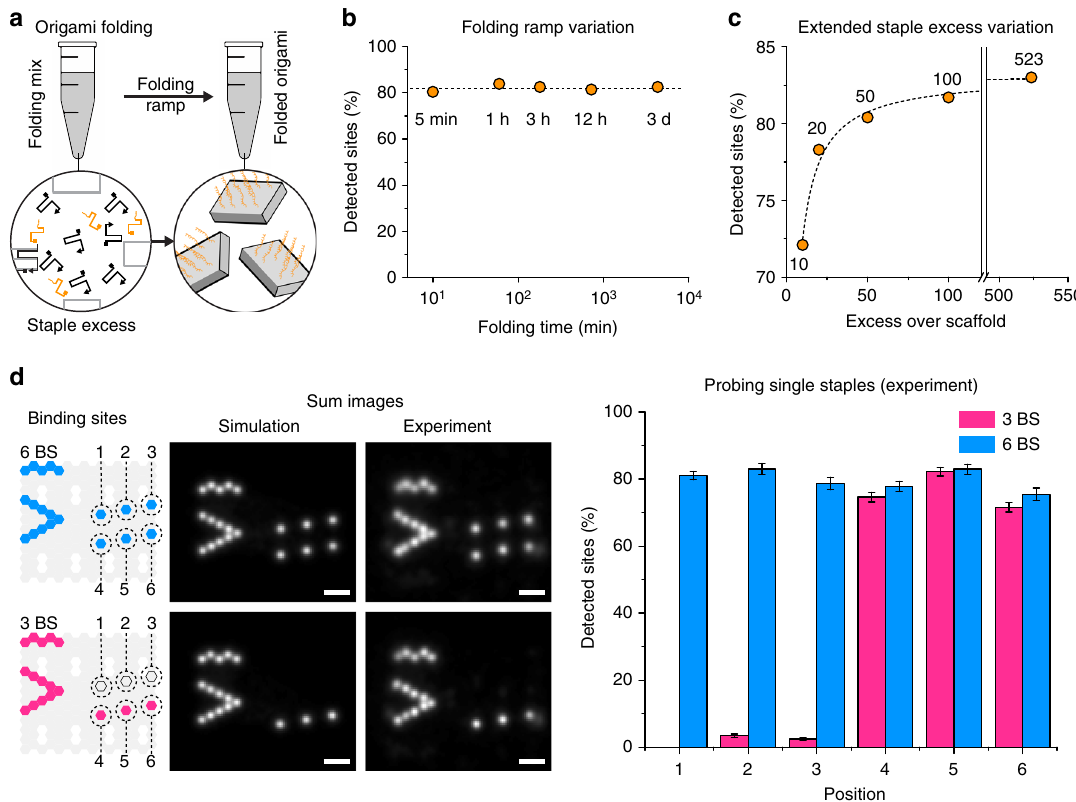
Fig. 3 In fl uence of folding conditions and experimental validation of accessibility of single sites. a Schematic folding of 20-nm-grids with the staples that carry detection sites in orange. b Percentage of detected sites as a function of folding time. The dashed line represents the mean of all 5 measurements (mean: ~82%). c Percentage of detected sites as a function of molar staple excess over scaffold. The dashed line represents the fi t of a Michaelis – Menten curve (saturation: 83%). d Schematics of the 6 BS (blue) and 3 BS (magenta) structures with the arrowhead + line alignment pattern, their DNA-PAINT sum images, and the percentage of detected sites depending on the position. Error bars represent the standard deviation and were generated by repeated ( n = 10) random selection of a subset of 250 structures from all selected structures of the whole fi eld of view. Scale bars, 20 nm in